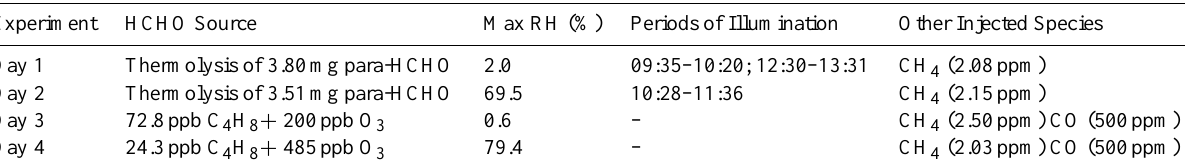
Table 2. Description of experimental conditions.